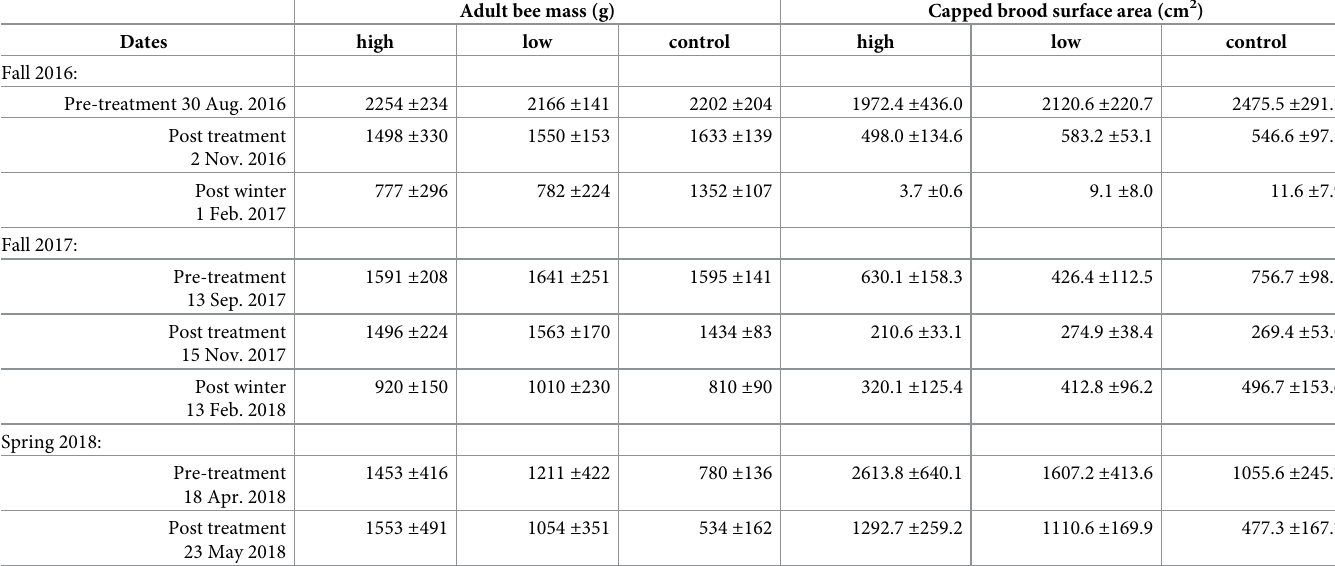
Table 1. Adult bee masses and brood surface areas for the Fall 2016, Fall 2017 and Spring 2018 field experiments. High, low and control refer to methoxyfenozide treatment